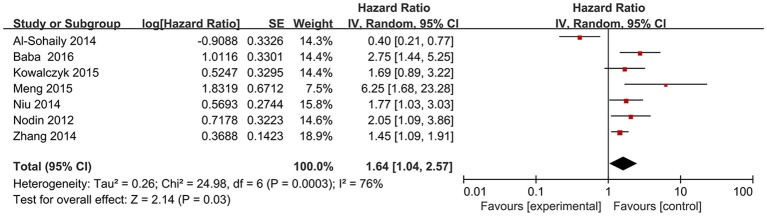
Forest plot of HR for the association between SATB1 expression and OS in CRC. OS, overall survival; CRC, colorectal cancer; HR, hazard ratios.